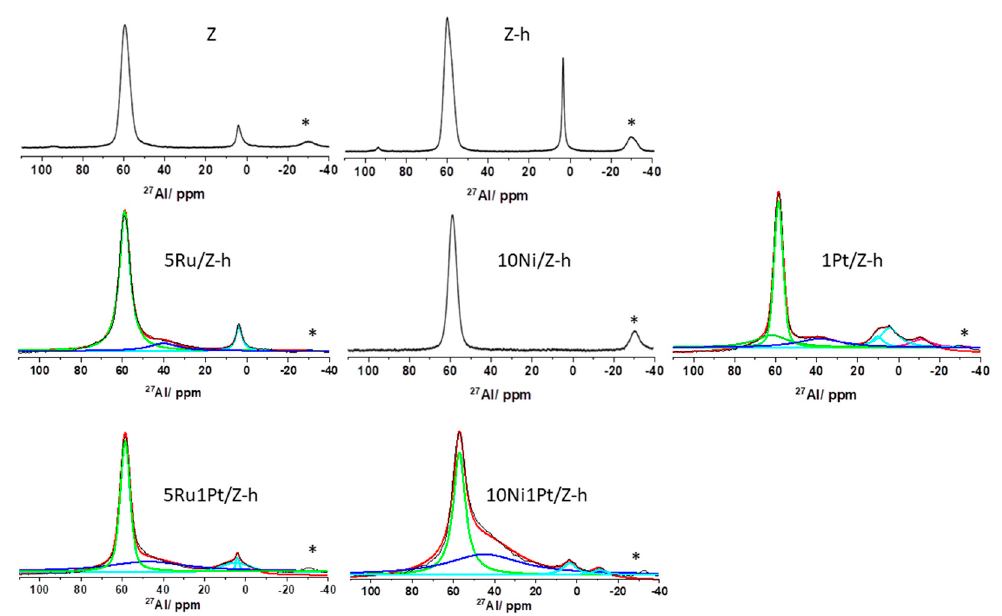
Figure 8. Experimental (black) and simulated (red) single-pulse 27 Al NMR spectra of the studied zeolites. The individual contributions of the different Al environments are given with colored lines (green, blue and cian). The FAl:EFAl ratio for ZSM-5 and ZSM-h was determined by direct integration of the two resonances. (* denotes a spinning side band).